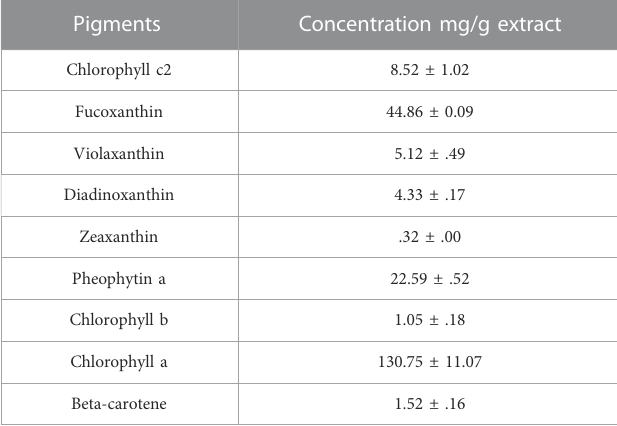
TABLE 2 Pigments content of the F. vesiculosus lipid fraction (SCCO 2 E) obtained using supercritical CO 2 extraction.